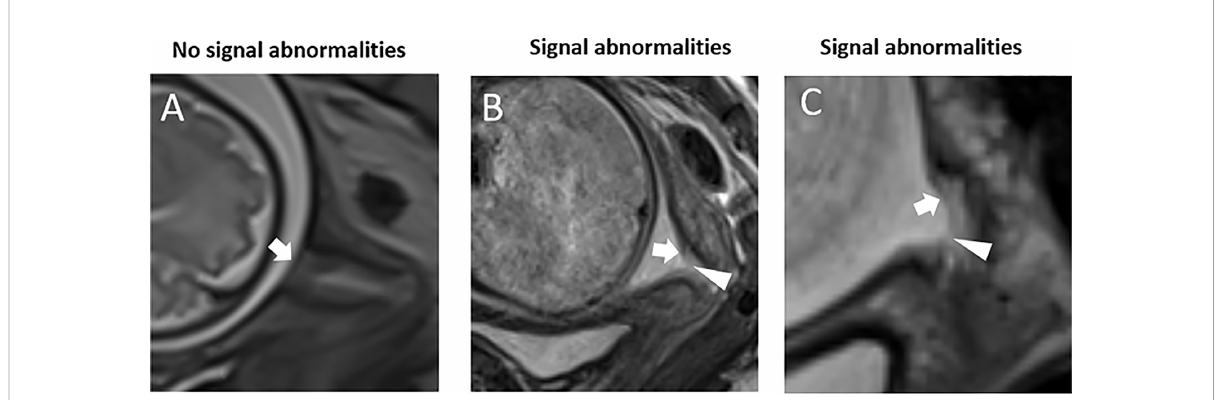
FIGURE 2 Fetal membrane signal abnormalities. T2WI of the cervix in the sagittal view. (A) A fetal membrane with no signal abnormalities at 32 weeks ’ gestation. (B) Prolapsed fetal membrane with a signal abnormality – partial defect of the continuous fetal membranes signal – at 32 weeks. (C) Prolapsed fetal membrane with a signal abnormality – local thinning and increased signal intensity of the continuous fetal membrane signal – at 28 weeks. White arrows indicate the fetal membrane, and white triangles indicate fetal membrane